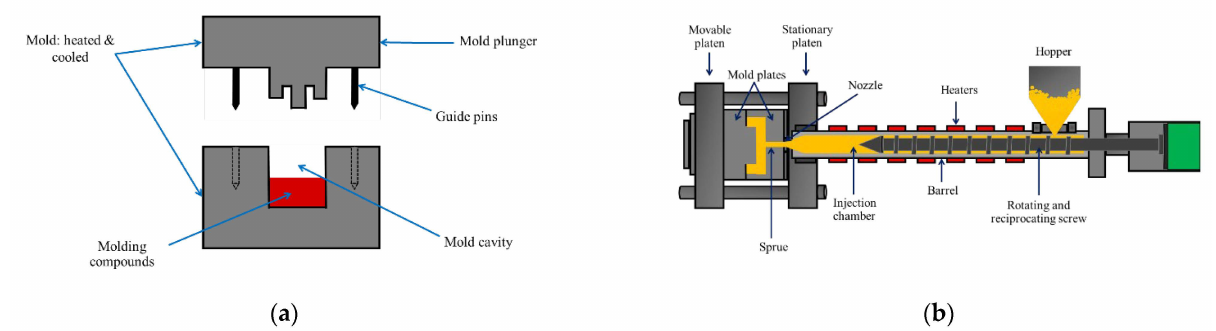
Figure 1. Examples of traditional manufacturing processes: ( a ) compression molding; ( b ) injection